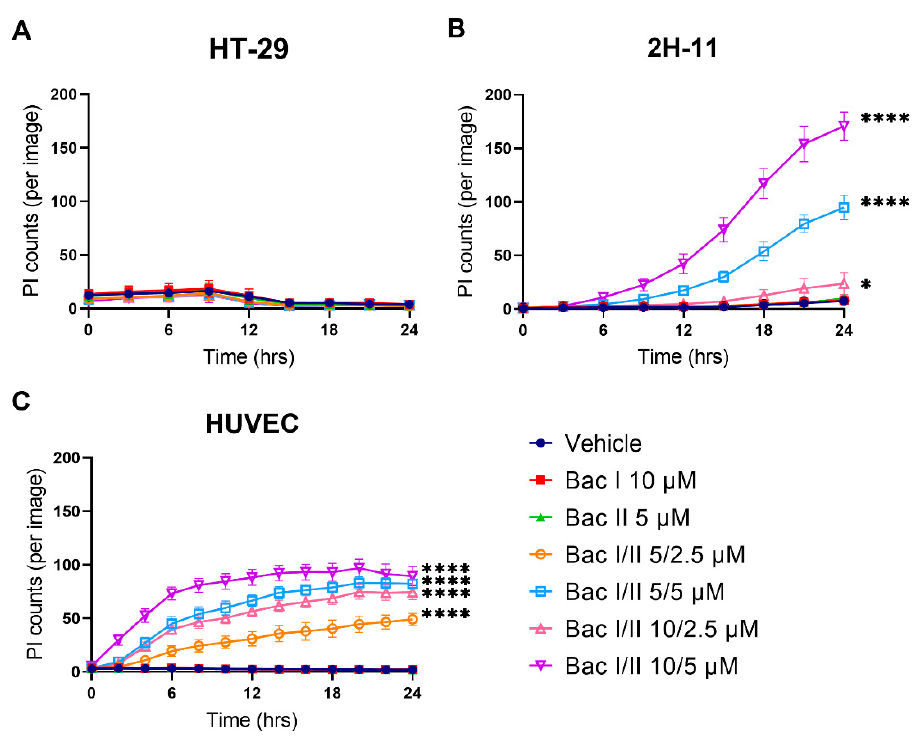
Figure 7. Disruption of the plasma membrane by bac I and II combined was cell line dependent. HT-29 ( A ), 2H-11 ( B ) and HUVEC ( C ) were treated with bac I and II, either alone or in combination, and the disruption of the plasma membrane was monitored over 24 h using propidium iodide (PI). Data represent the mean number of PI-stained cells per image for 6 replicates. Error bar represents SD. Significant difference as compared with vehicle after 24-h treatment is indicated by asterisks * p < 0.05; **** p < 0.0001).